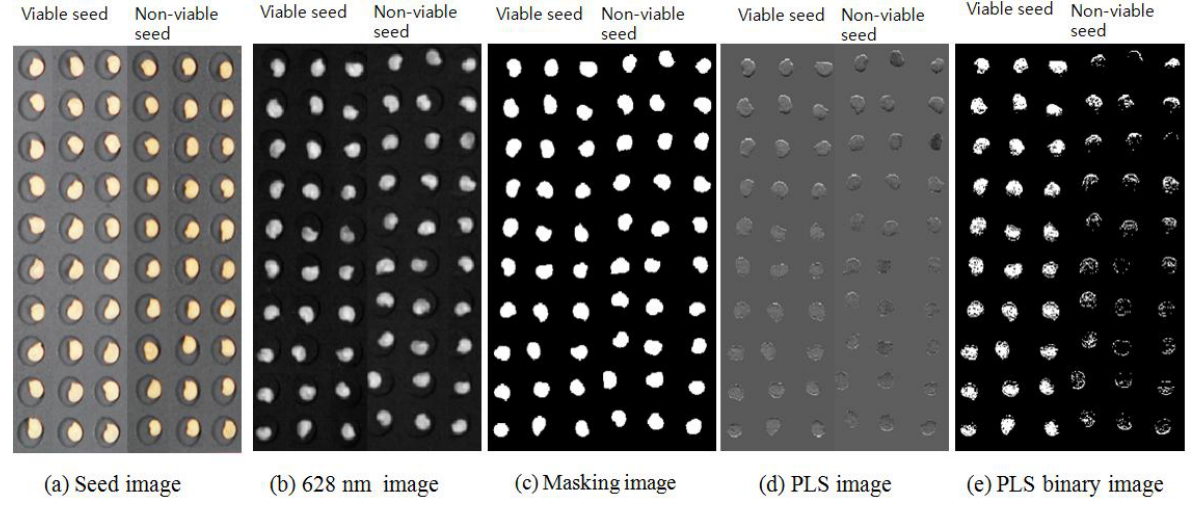
Figure 8. PLS image processing to classify viable and nonviable pepper seeds.